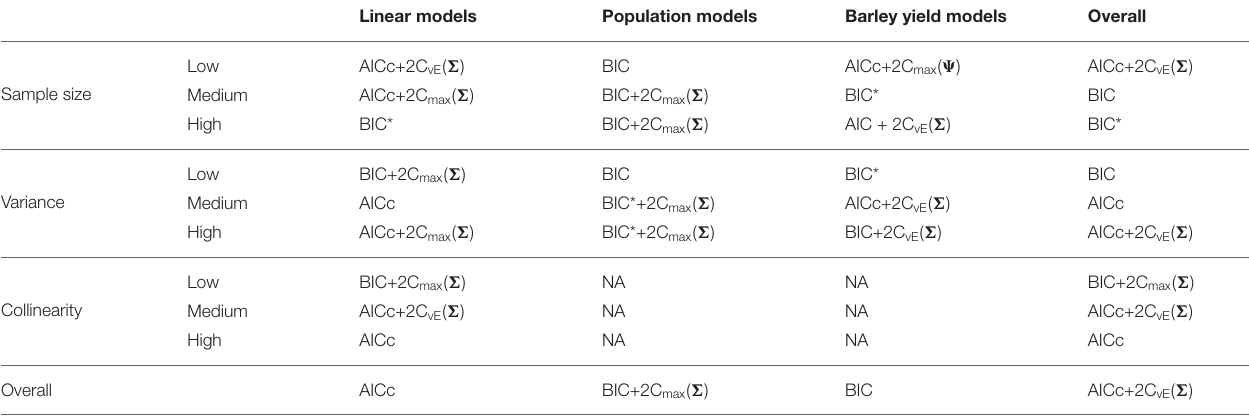
TABLE 5 | Best performing information criteria at selecting the optimal predictive model from the candidate set.